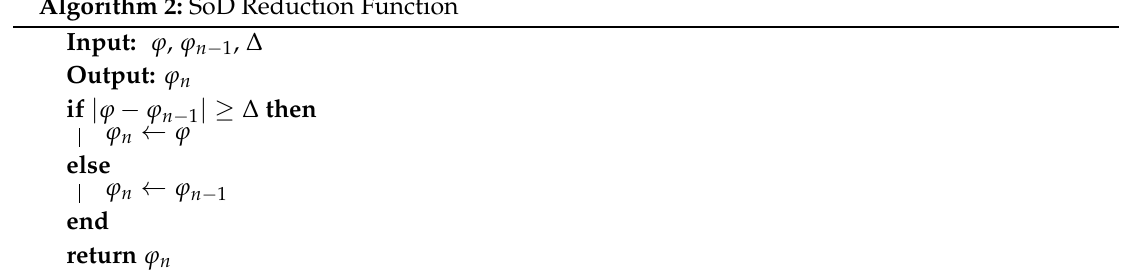
Algorithm 2: SoD Reduction